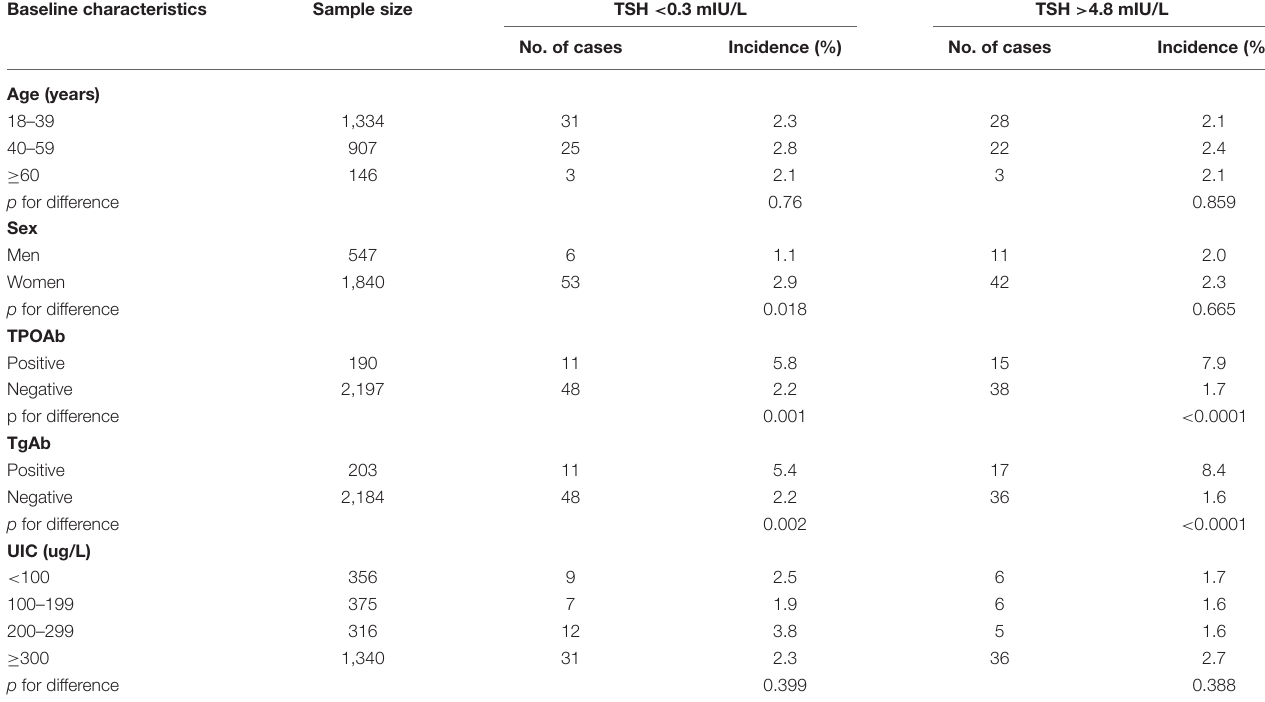
TABLE 2 | Incidence of abnormal TSH levels by risk